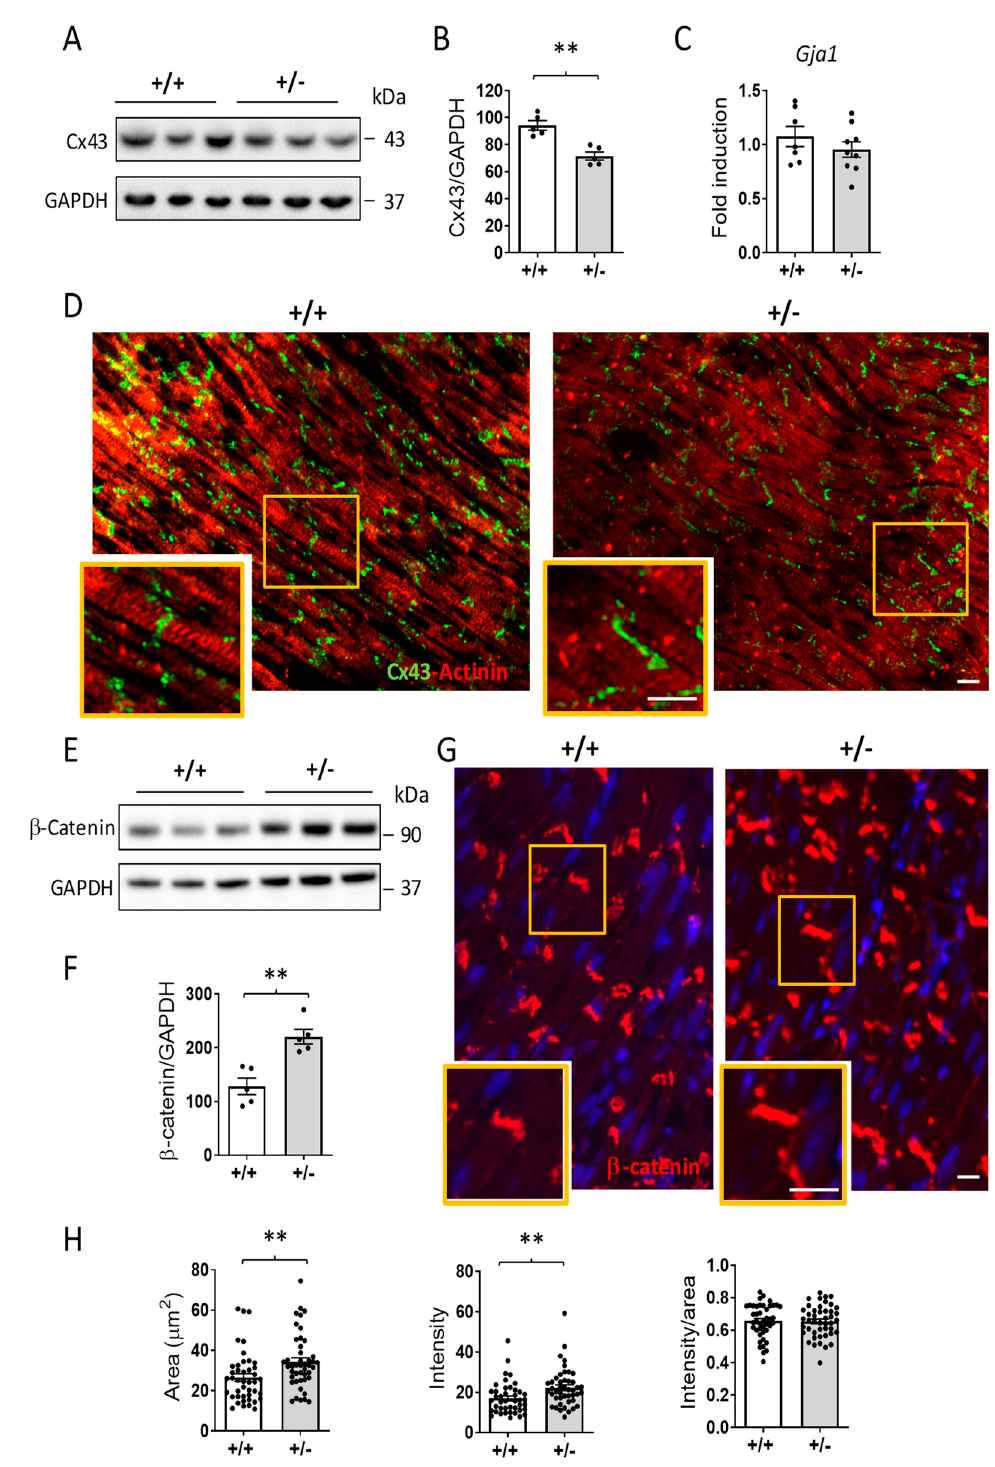
Figure 3. Connexin 43 and β -catenin expression in the heart of Cdkl5 +/ − mice. ( A ) Example of an immunoblot showing connexin 43 (Cx43) and GAPDH levels in extracts of ventricular heart tissue of Cdkl5 +/+ (n = 3) and Cdkl5 +/ − (n = 3) mice. ( B ) Histogram showing quantification of connexin 43 (Cx43) protein levels normalized to GAPDH in extracts of ventricular heart tissue from Cdkl5 +/+ (n = 5) and Cdkl5 +/ − (n = 5) mice. Data are expressed as percentages of Cdkl5 +/+ mice. ( C ) Relative gap junction protein alpha 1 ( Gja1 ) mRNA expression in ventricular tissue isolated from the heart of 3-month-old Cdkl5 +/+ (n = 6) and Cdkl5 +/ − (n = 9) mice. Data are presented as fold change in comparison with cardiac tissue from Cdkl5 +/+ mice. ( D ) Representative fluorescence images of ventricular